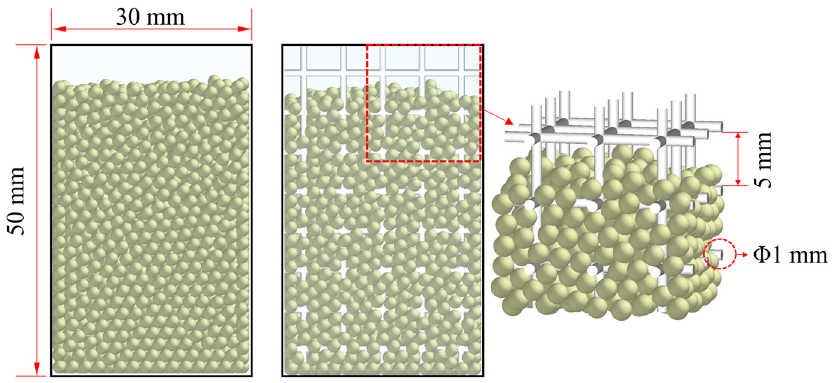
Figure 1. Particle damper model.